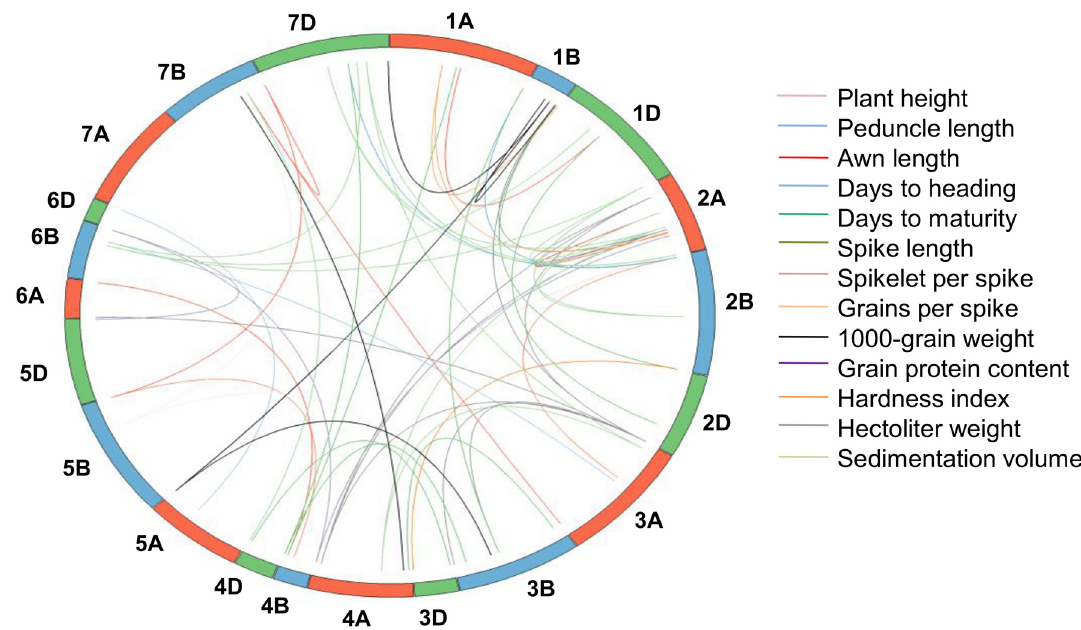
Fig 10. Epistatic interactions using main effect markers (identified by SLST, MLMM and MTMM) for 13 traits. Cut off p-value for significant interaction is (cid:1) 0.001. Interactions for different traits are represented by different coloured lines.